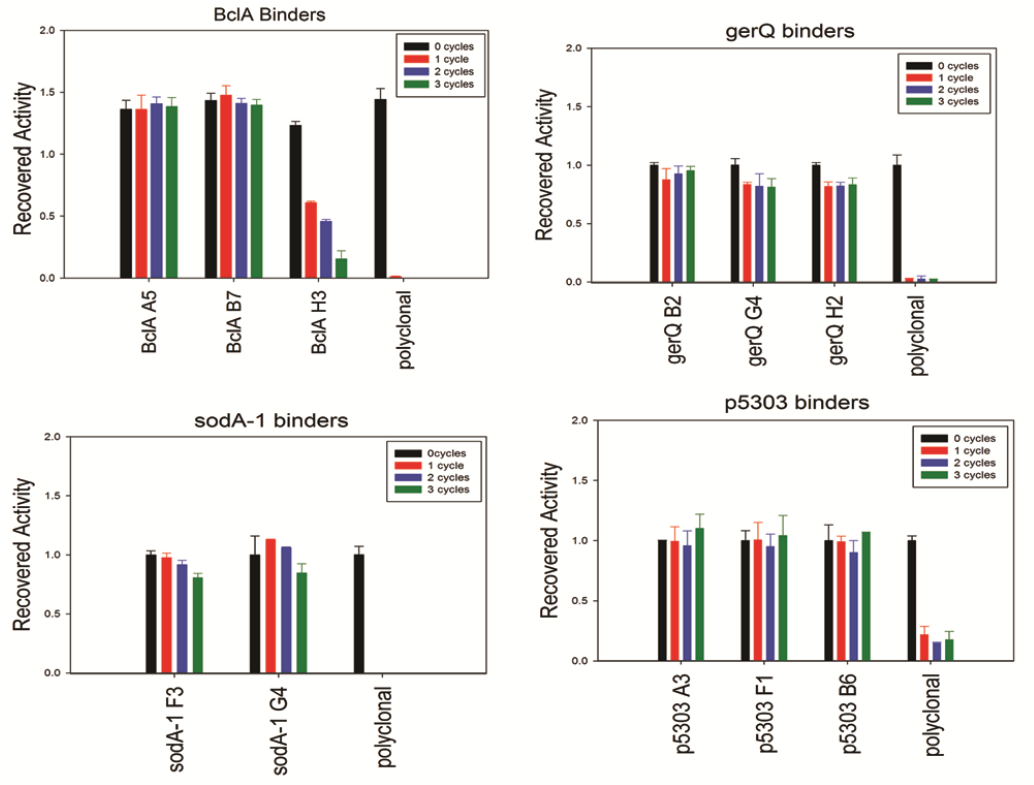
Figure 4. Binding activity after iterative cycles of heating and cooling was assayed using a direct ELISA and biotinylated sdAbs. An HRP-conjugated streptavidin served as the secondary detection